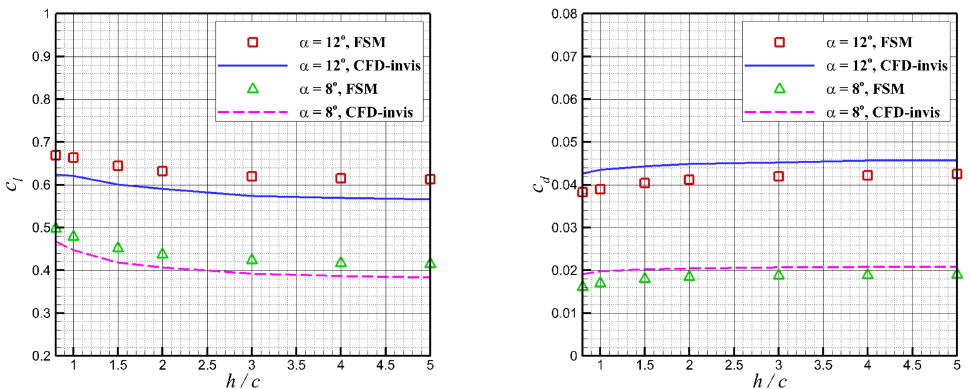
Figure 23. Variation in lift and drag coefficient with ground height. For α = 12 ◦ , the different shapes of the jet boundary at h = 0.8 c and h = + ∞ are compared in Figure 24.